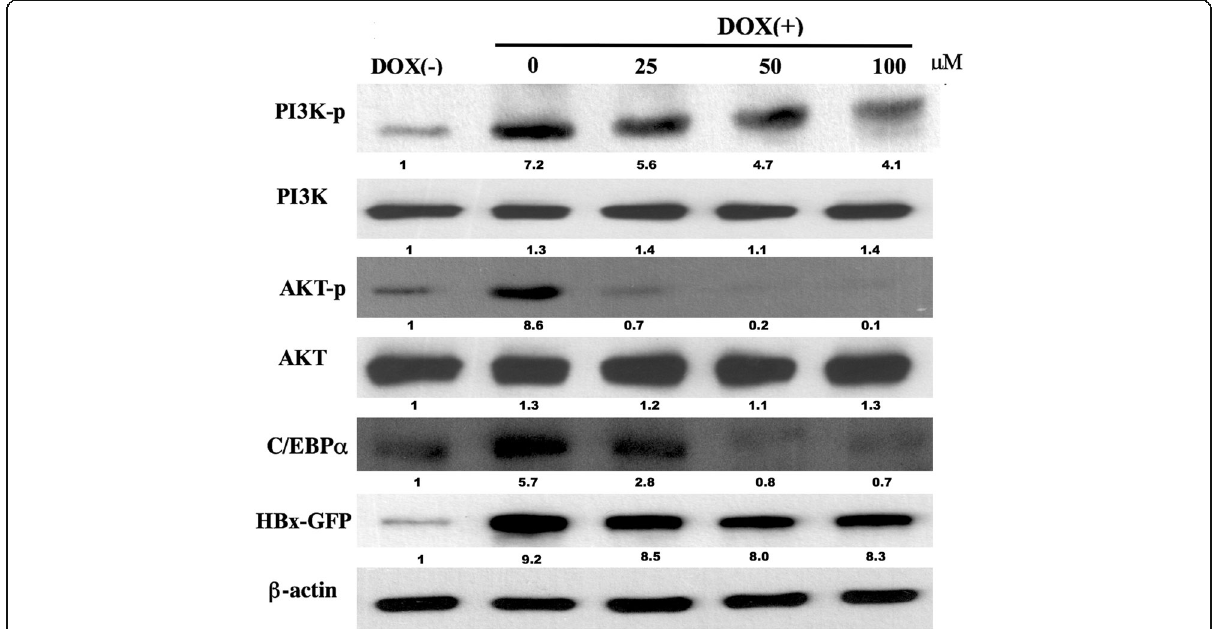
Fig. 5 Effect of naringenin on HBx-induced AKT- signaling pathways. HepG2-HBx-GFP cells were pretreated with 0 – 100 μ M naringenin before